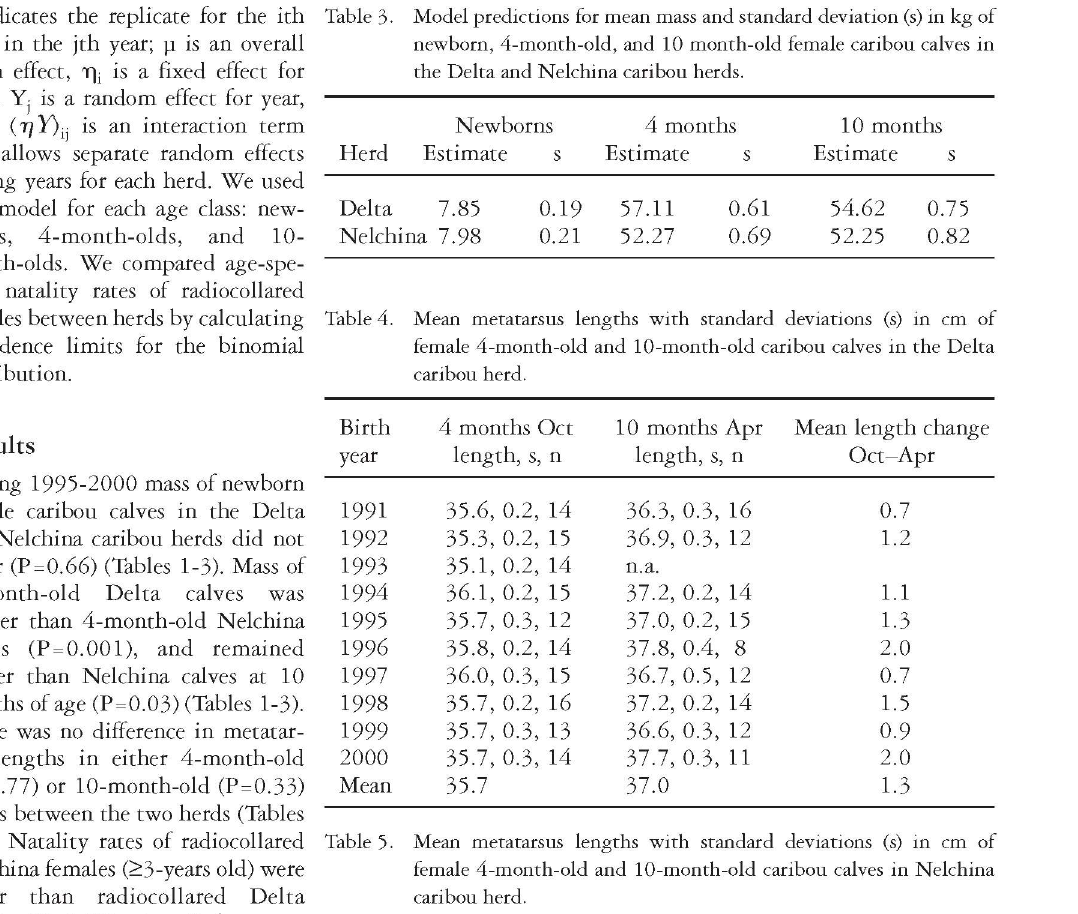
Table 5. Mean metatarsus lengths with standard deviations (s) in cm of female 4-month-old and 10-month-old caribou calves in Nelchina caribou herd.